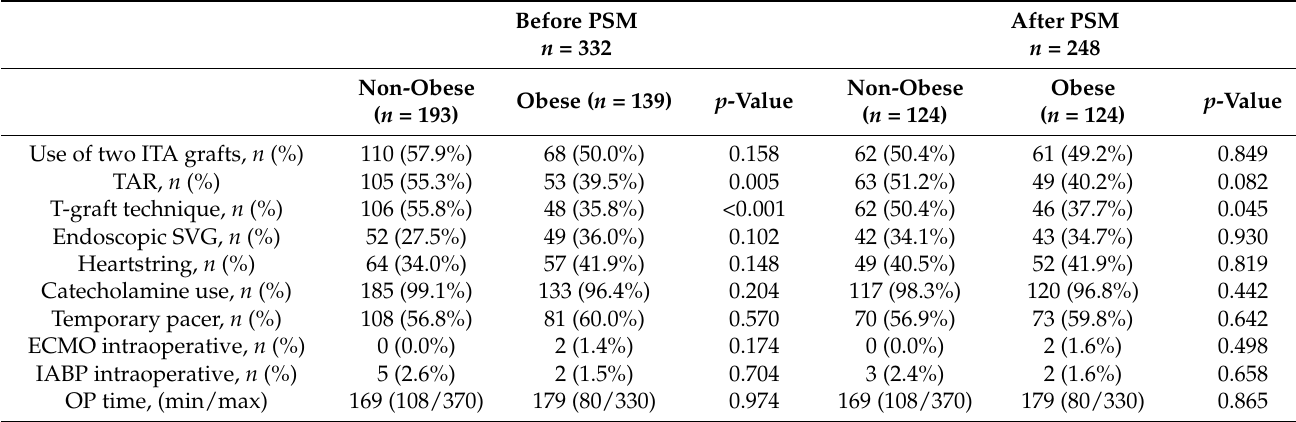
Table 2. Intraoperative data.